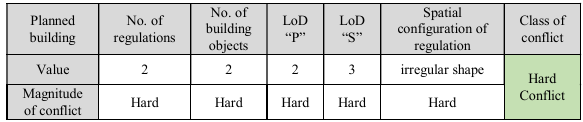
Table 6. Classification of the magnitude of building height and overshadowing regulations conflict